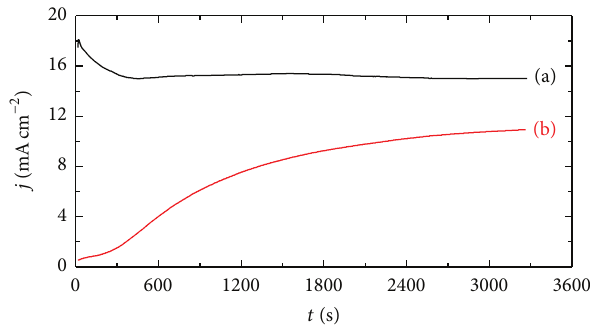
Figure 7: Potentiostatic current-time curves obtained at − 0.35 V versus Ag/AgCl for the API X70 pipeline steel electrode after (a) 1 hour and (b) 20 h immersions in the Arabian Gulf